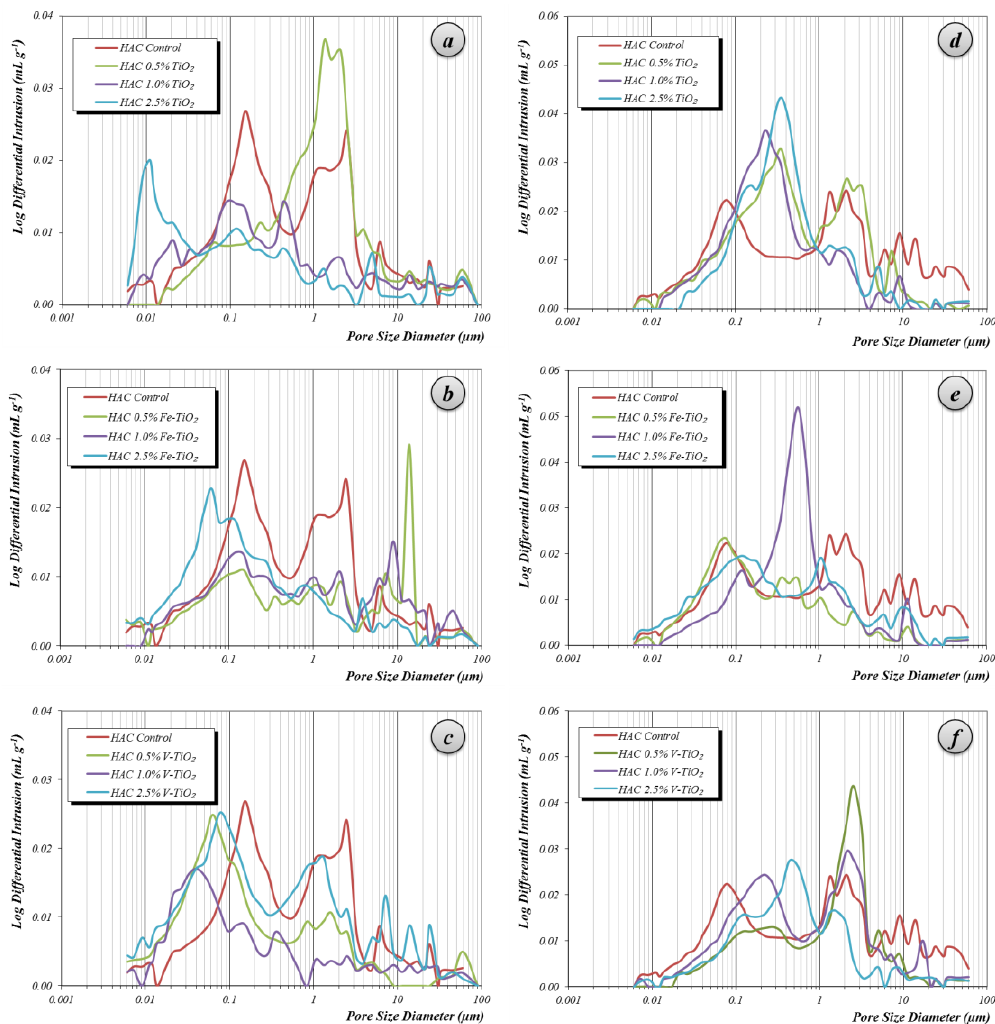
Figure 9. Pore size distribution of HAC mortars with photocatalysts after: ( a – c ) 28 curing days at curing condition 1, 20 °C and 95% RH; ( d – f ) 28 curing days at curing condition 2, 60 °C and 100% RH.